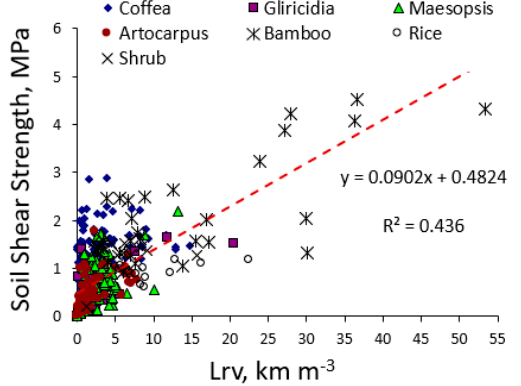
Figure 7. Regression of soil shear strength at 5 cm depth on root length density (L rv ) of various plant species in the layer 0–10 cm.